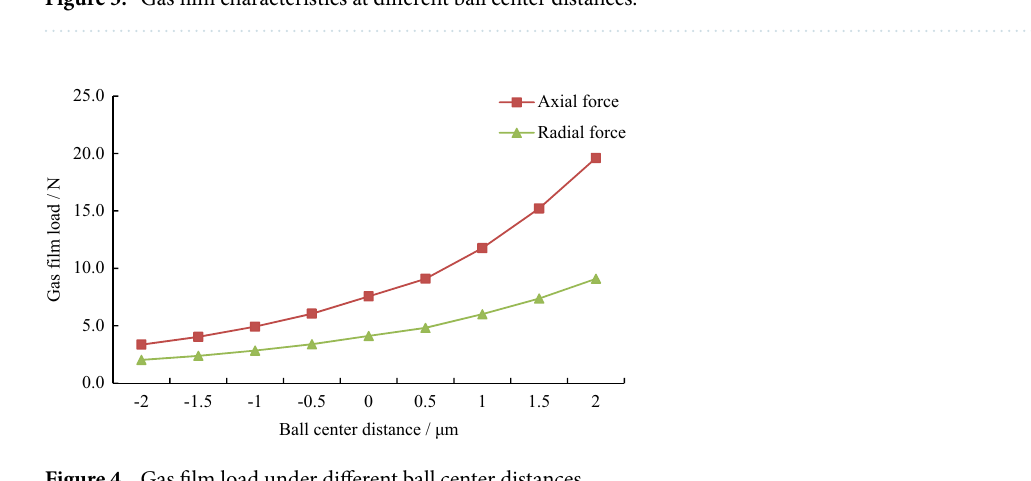
Figure 3. Gas film characteristics at different ball center distances.